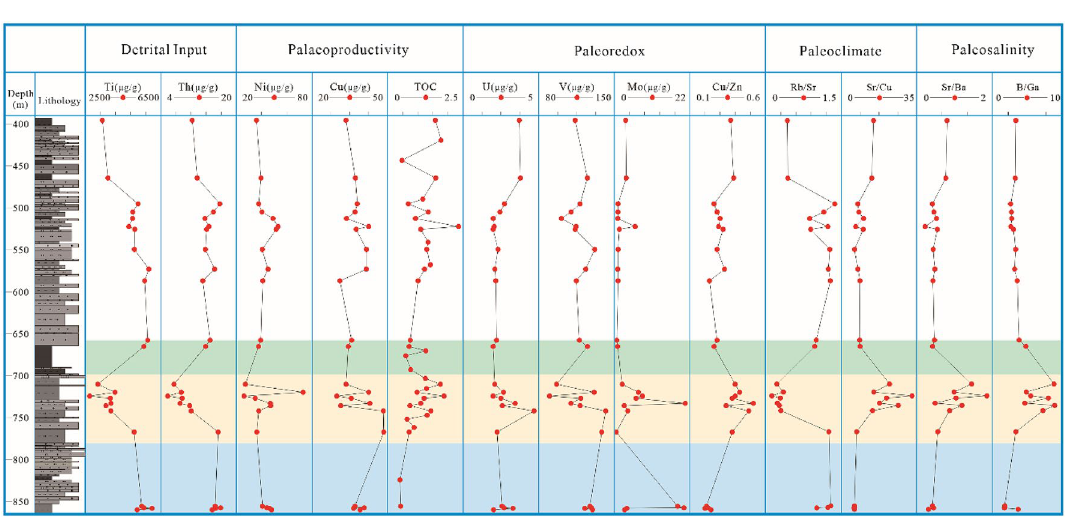
Figure 7. Vertical variations in detrital input indices (Ti, Th), paleoredox indices (U, V, Mo, and Cu/Zn), paleoproductivity indices (Ni, Cu and TOC), paleoclimate indices (Sr/Cu and Rb/Sr), paleosalinity indices (Sr/ Ba and B/Ga) for the Xiahuapidianzi Formation in Hongmiaozi